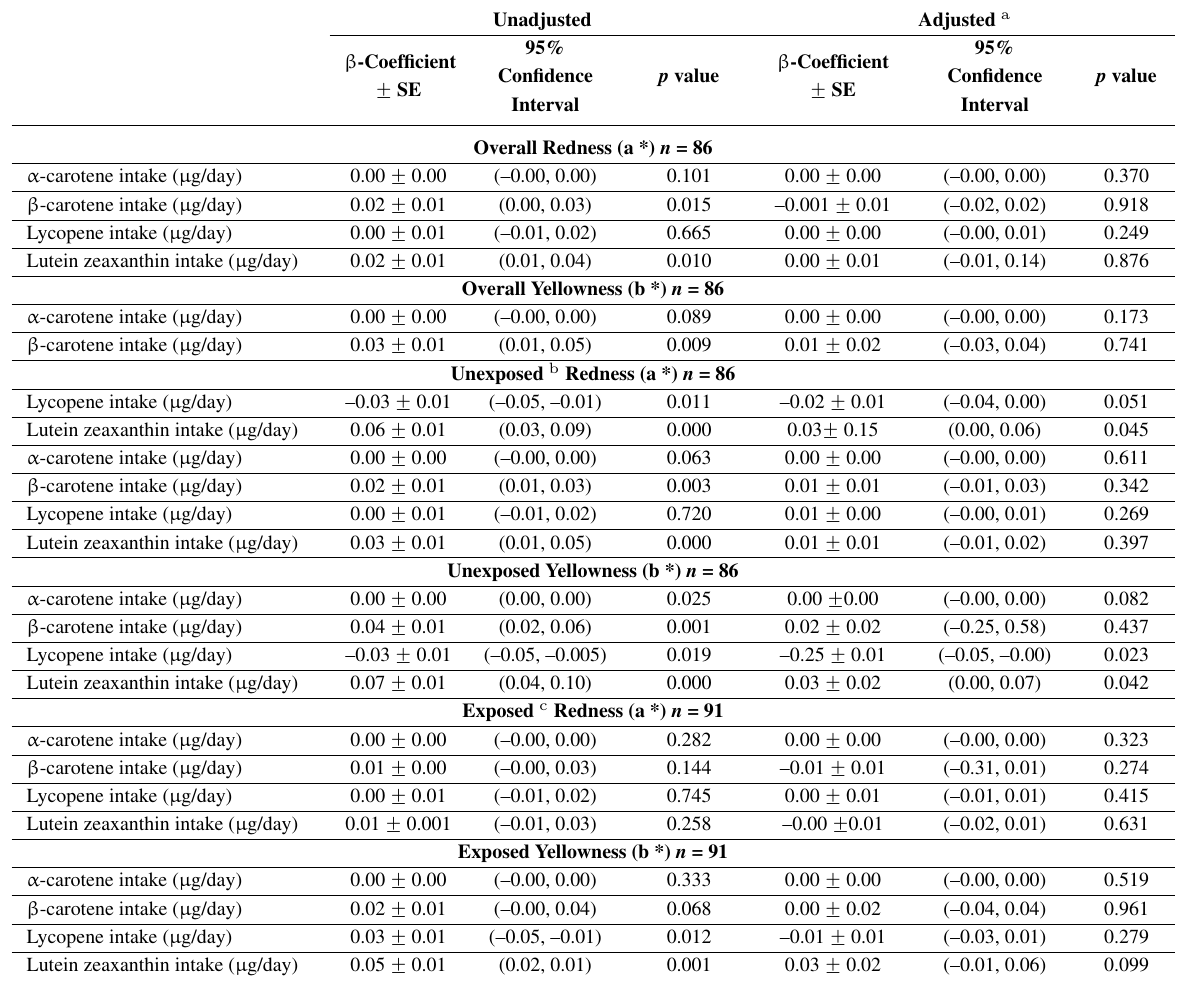
Table A1. Multiple regression analyses between dietary carotenoid intake and skin color (CIE